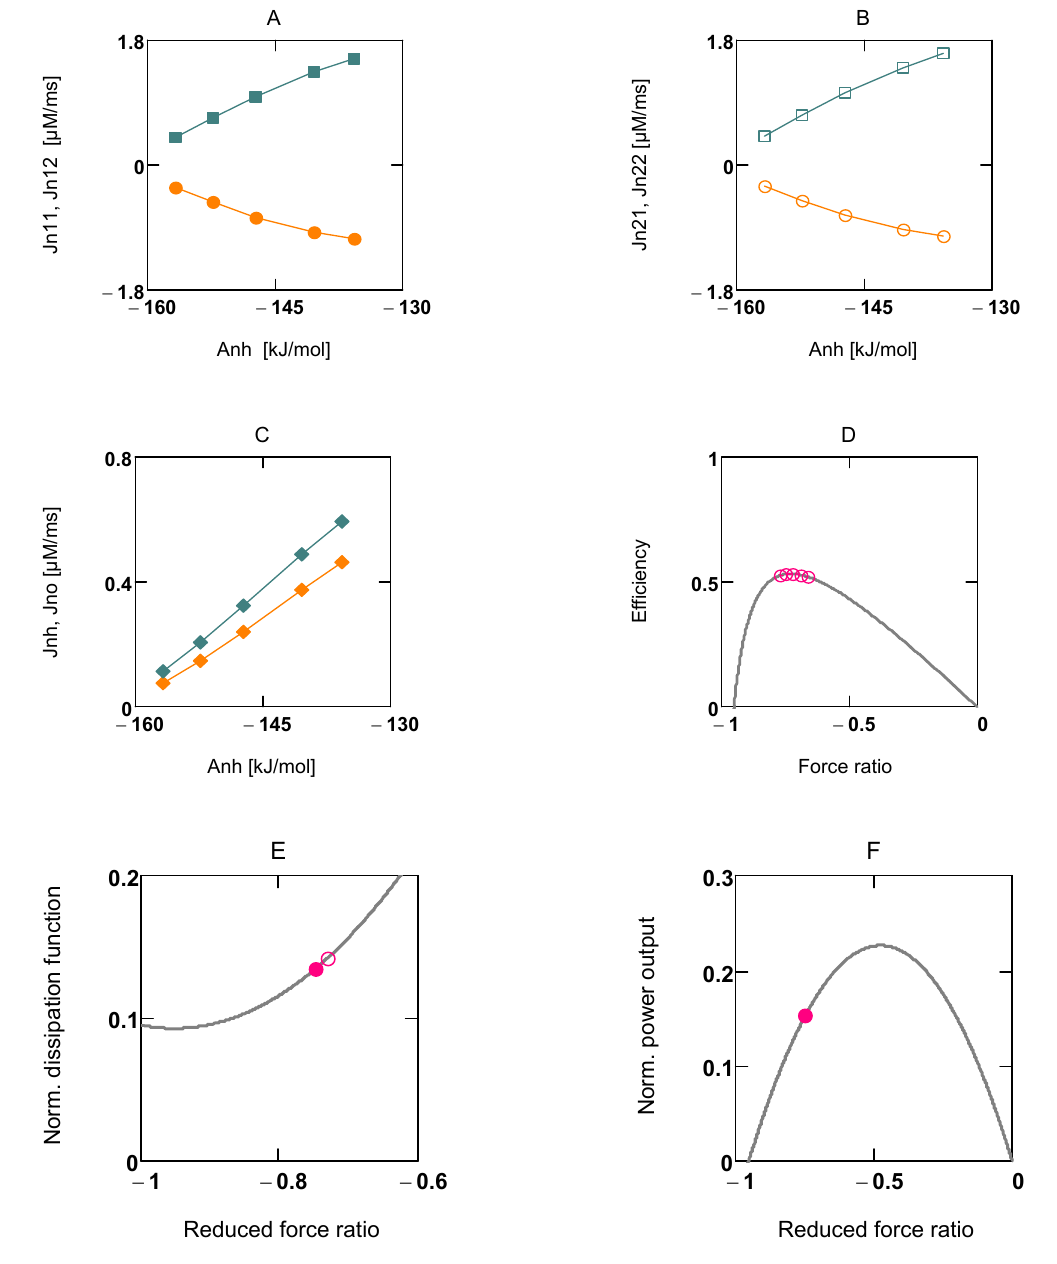
Figure 4. NET analysis of J as a two-flux-system. h J and o J are both uncoupled by NA NA NA h q = 0.952, Z = 1.0). A: (filled circles) Jn11, (filled squares) Jn12, both  = o  = 0.05 ( n n n n versus Anh; B: (open circles) Jn21, (open squares) Jn22, both versus Anh; C: (orange diamonds) Jnh, (green diamonds) Jno, both versus Anh; D: efficiency versus force ratio A , (open circles) results from simulation; (line) analytical results according to (10  ); E: normalized dissipation function versus reduced force ratio x , (filled circle) result from simulation, (open circle) result from simulation, but at x (abscissa of maximal max efficiency), (line) analytical curve according to A20a; F: normalized power output versus SIM x , (filled circle) result from simulation, (line) analytical curve according to A20b; Pyr OP